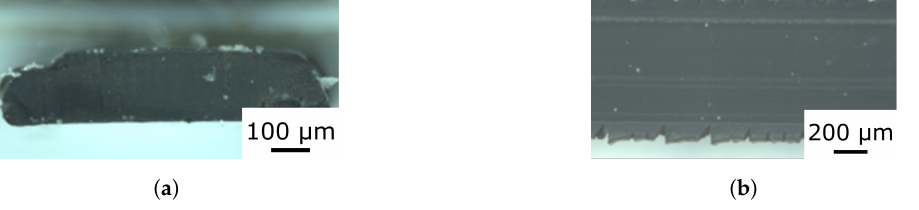
Figure 4. Cross-section and top view of the printed sensory threads creating the 3D sensing fiber network. ( a ) Cross-Section; ( b ) Top